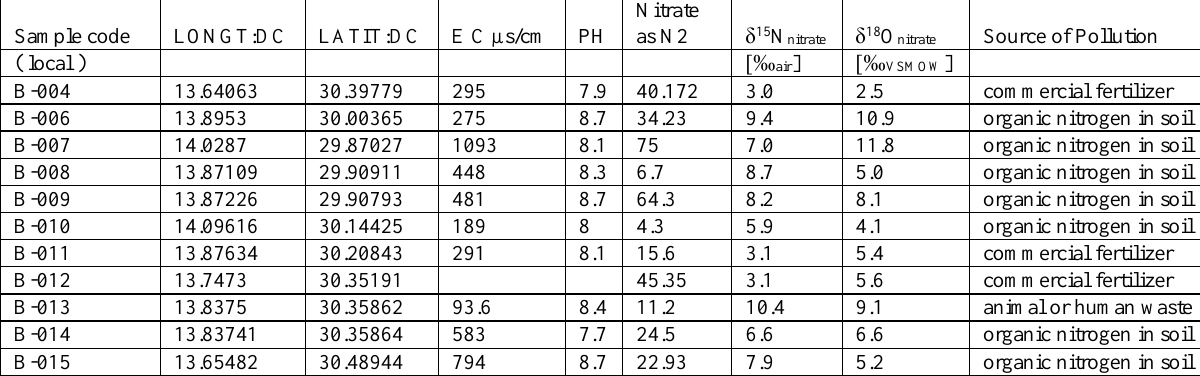
Table (3) Stable Isotopes Result and Source of